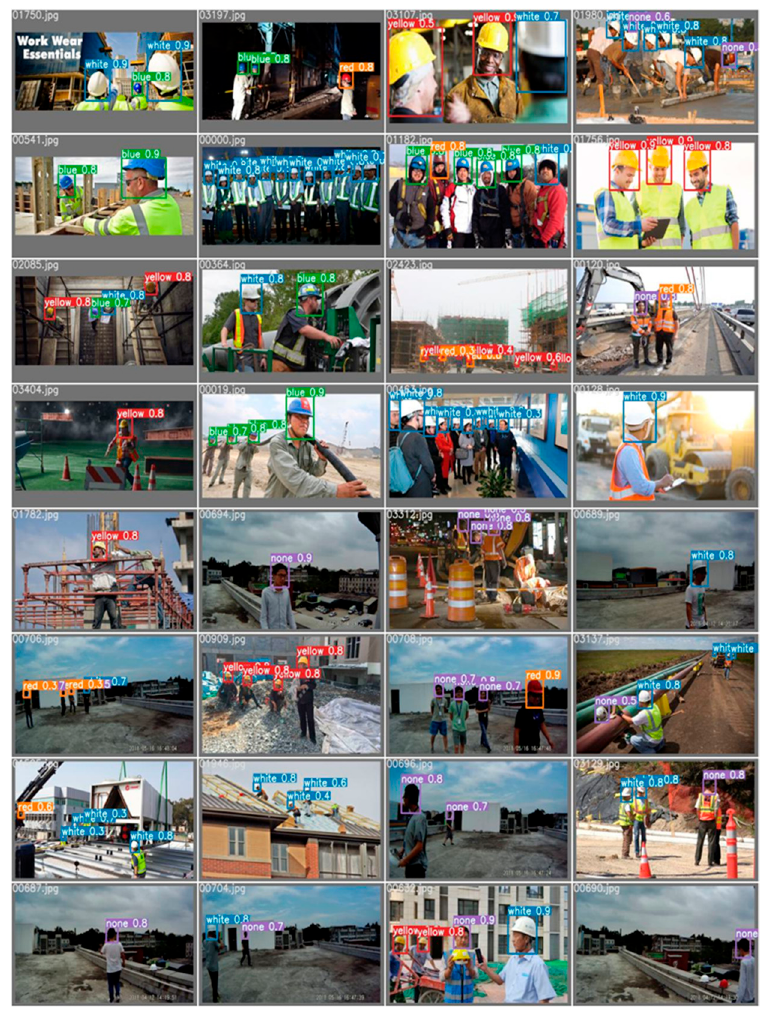
Figure 6. Example of test results.